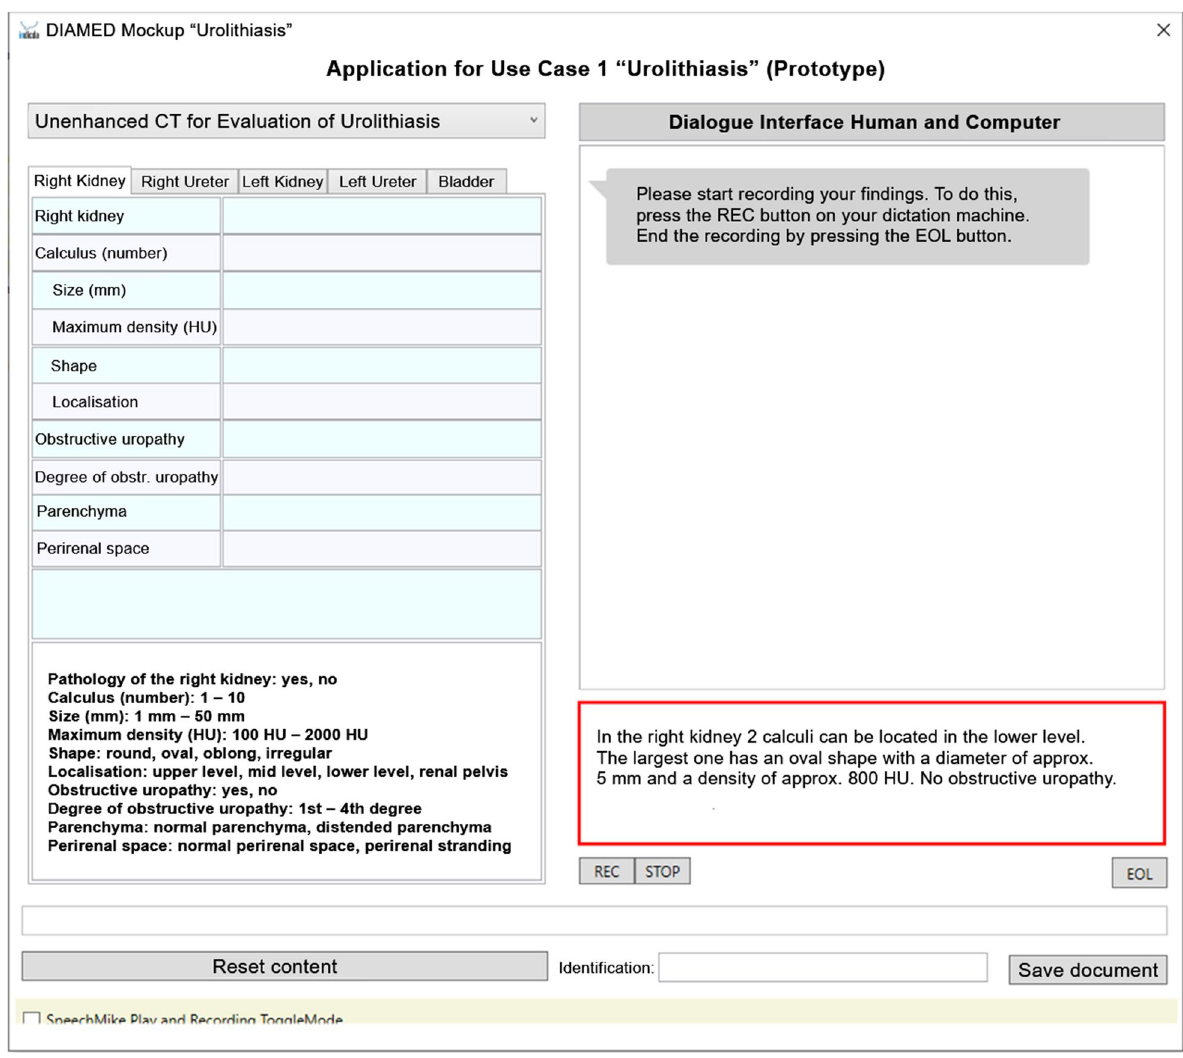
Fig. 2 Screenshot of the reporting tool’s graphical user interface (translated from German to English language). On the left side, the to-be-completed SR template is shown, including content suggestions at the bottom. On the right side, the reporting window (bottom) and the dialogue window (top) are shown. The radiologist has started reporting in a free-text form using speech